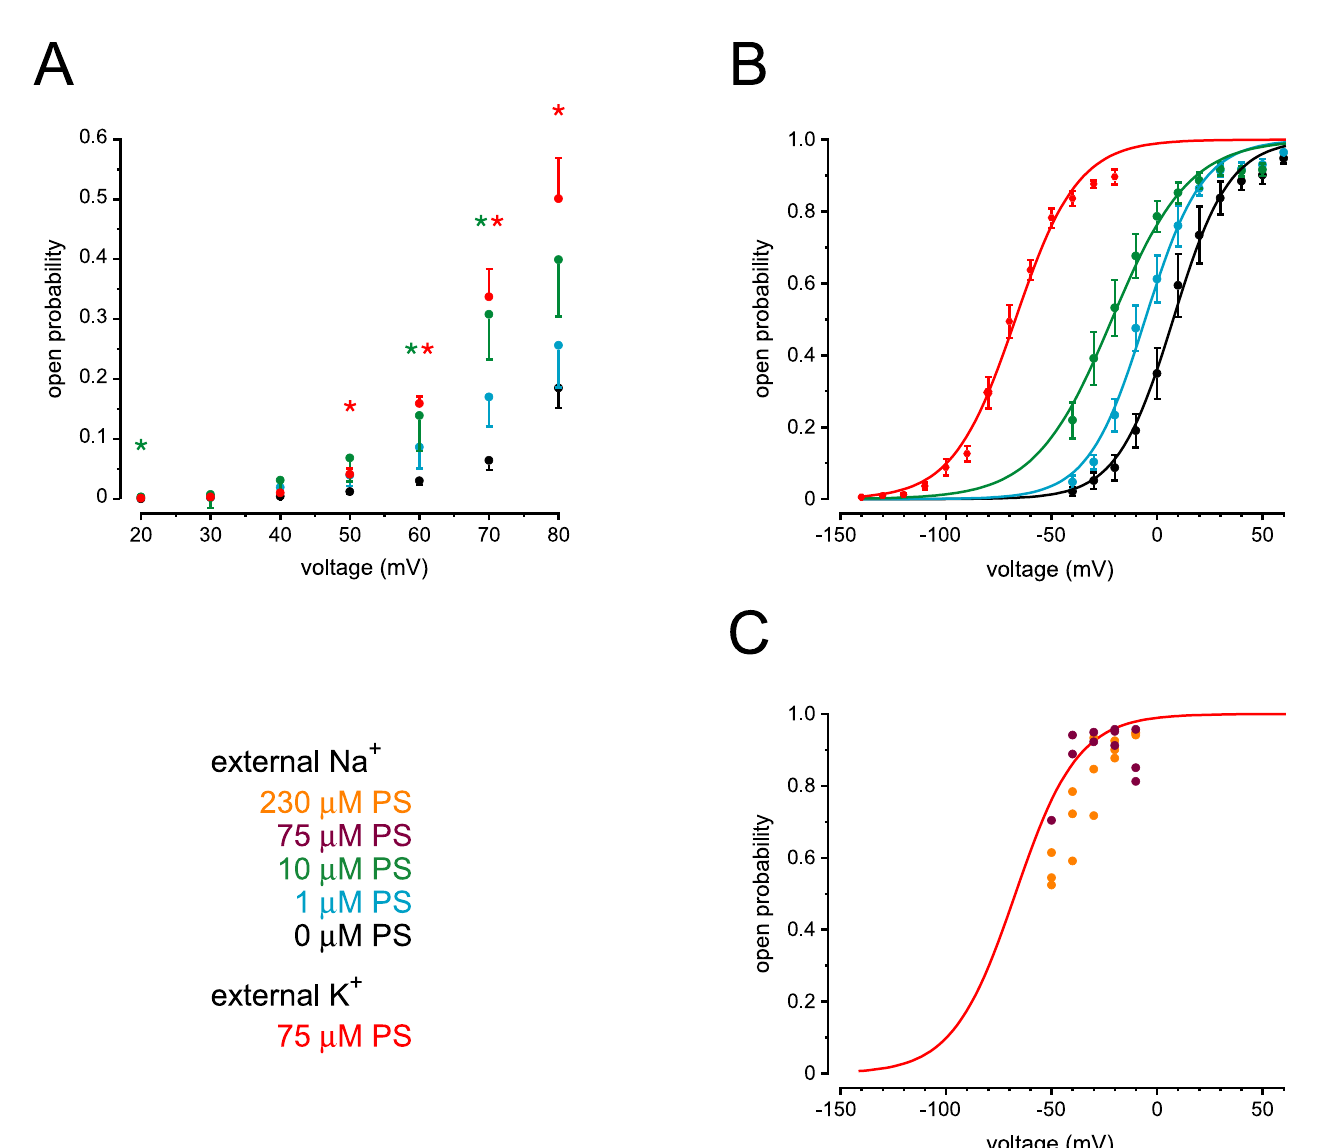
Fig 2. Dependence of channel activation on voltage and pregnenolone sulfate concentration. (A) Channel open probability was measured as a function of membrane potential. Cytoplasmic solutions contained 0.1 μ M free Ca 2+ . The pipette contained pregnenolone sulfate (0 μ M to 75 μ M as indicated) dissolved in an external solution that also contained 0.3% ( w / v ) DMSO. Each point shown is the mean of measurements in 4 to 8 cilia. � Significantly different from 0 μ M pregnenolone sulfate for the given voltage, P < 0.001–0.014, t -tests and Mann-Whitney rank sum tests controlled by false discovery rate correction for 21 comparisons. (B) The same procedures as in A but with 3 μ M cytoplasmic free Ca 2+ . The external (pipette) solution included pregnenolone sulfate (0 μ M to 75 μ M as indicated). Each point shown is the mean of measurements in 4 to 11 cilia. The solid smooth curves represent best fits of the open probability-voltage relations to Boltzmann functions as described previously [19]. Constants and strength and significance of fit for the best-fitting Boltzmann functions are given in S1 Table. Representative single-channel recordings are shown in S2 Fig. (C) Responses in standard external solution to which was added 75 μ M (purple circles) or 230 μ M (orange circles) pregnenolone sulfate. As in (B), cytoplasmic solutions contained 3 μ M free Ca 2+ . The red Boltzmann function is copied from (B) (response to 75 μ M pregnenolone sulfate with a KCl-based external